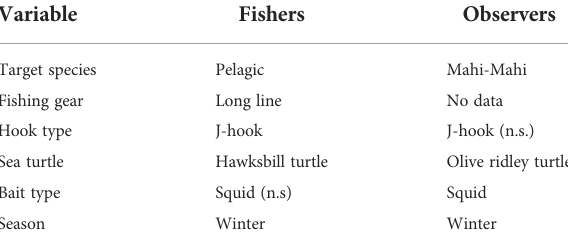
TABLE 3 Comparison of the variables studied between the fi shers and observers.